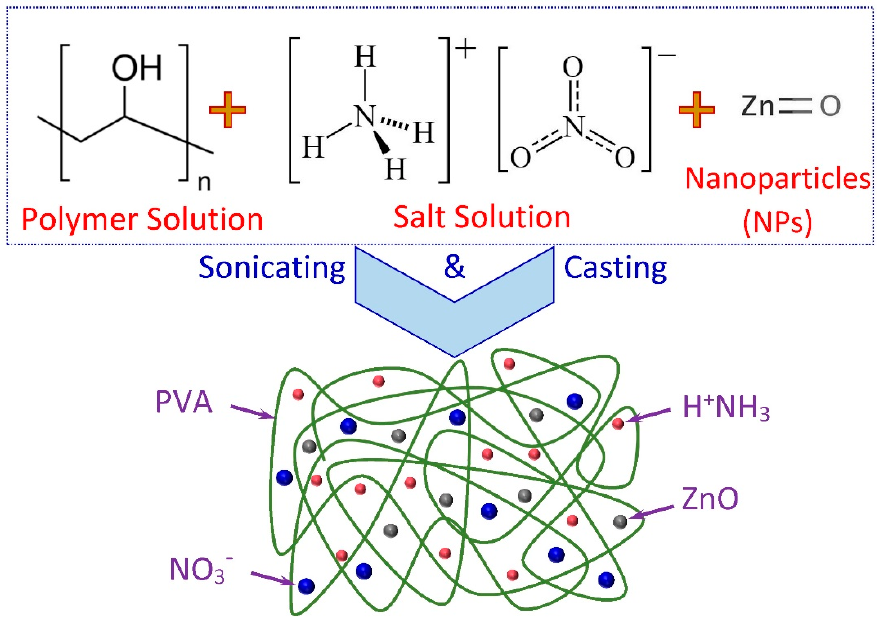
Figure 1. Sample preparation and characterization scheme for proton-conducting polyvinyl alco- hol (PVA)/NH 4 NO 3 /ZnO nanocomposite solid polymer electrolytes (NSPEs). (PVA)/NH 4 NO 3 /ZnO nanocomposite solid polymer electrolytes